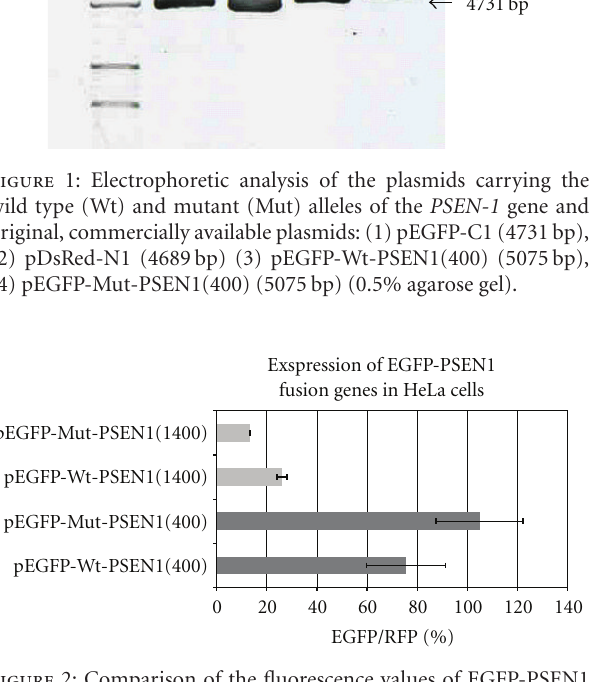
Figure 2: Comparison of the fluorescence values of EGFP-PSEN1 fusion proteins expressed from the EGFP-PSEN1 gene coding plasmids. Plasmids pEGFP-Wt PSEN1(1400) and pEGFP-Mut PSEN1(1400) contain full length (1404 bp) wild type (Wt) and mutein (Mut) (C → G 1174) PSEN1 gene introduced at the 3 (cid:2) -UTR of EGFP gene; plasmids pEGFP-Wt-PSEN1(400) and pEGFP-Mut- PSEN1(400) contain insert with shorter version (344bp) of PSEN1 (Wt or Mut) introduced at the 3 (cid:2) -UTR of the EGFP